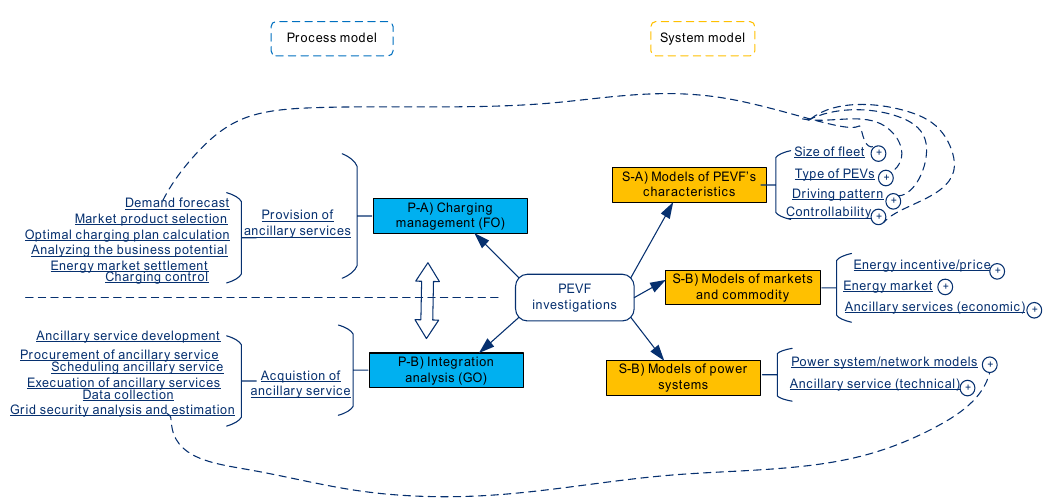
Figure 4. Process models and system models combined for ancillary services coordination between FOs and GOs.